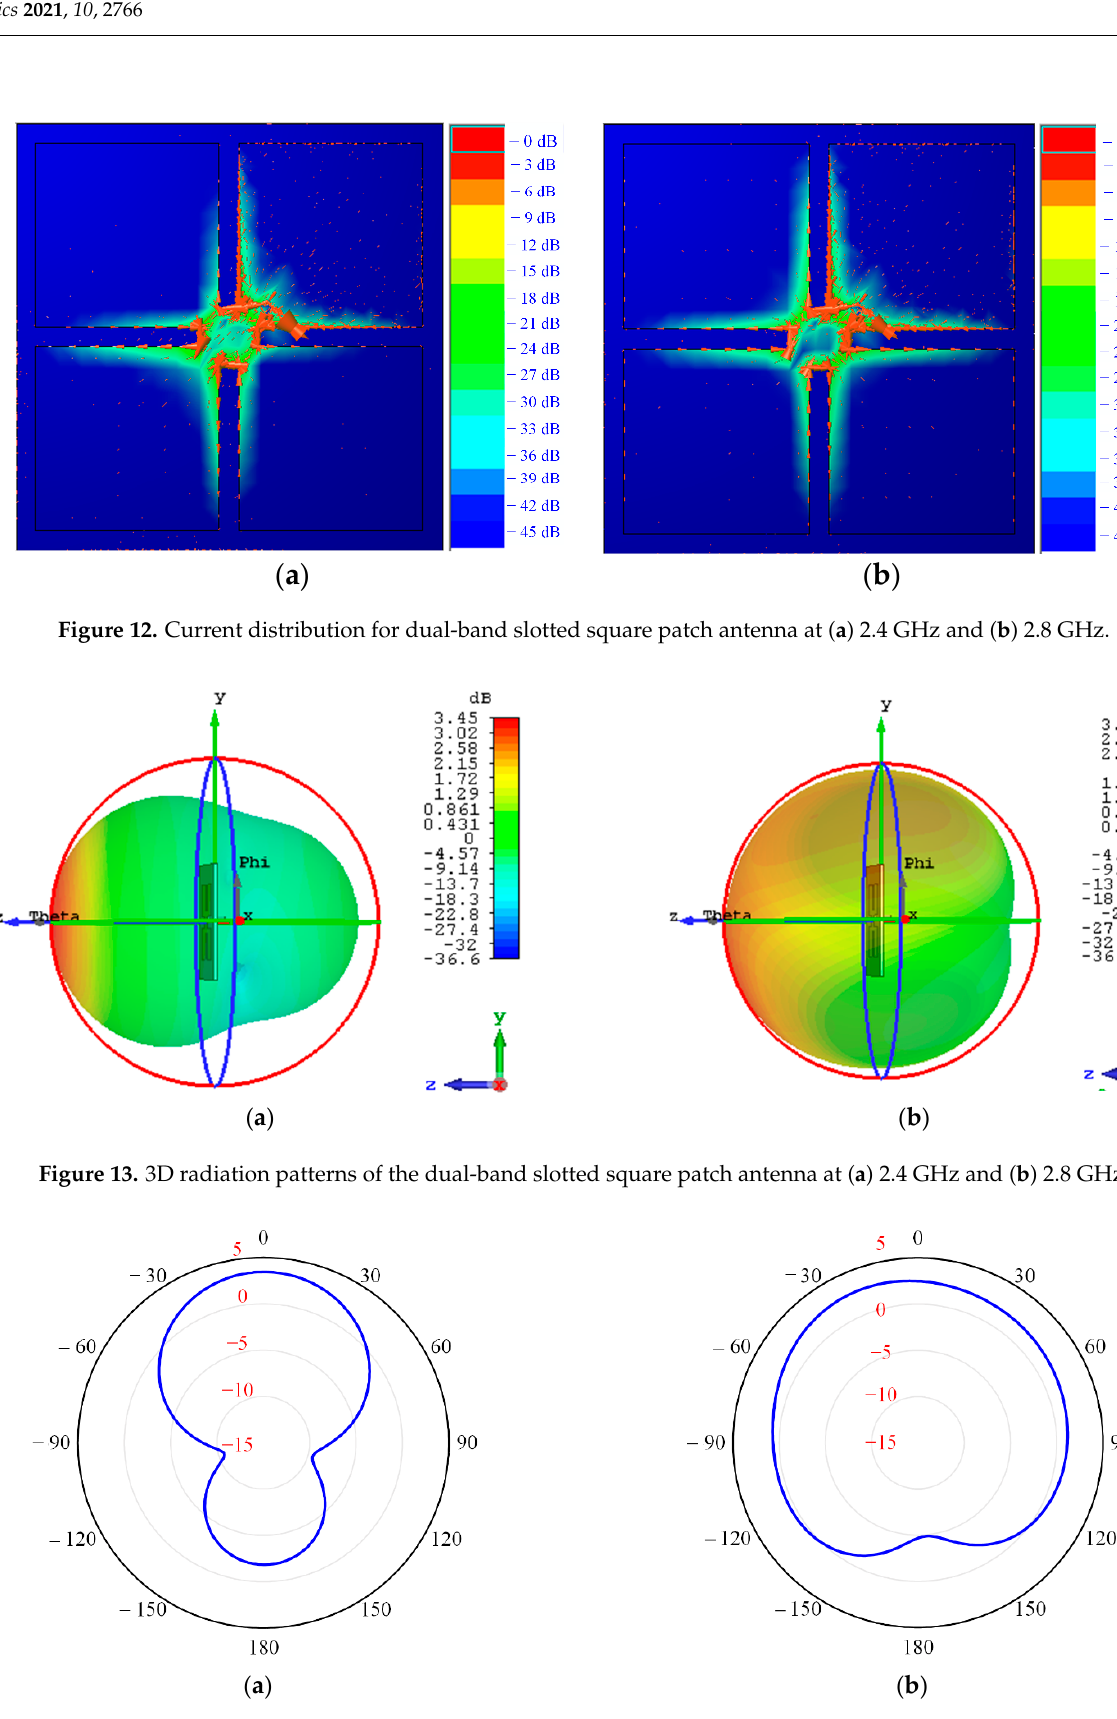
Figure 14. 2D radiation patterns of the dual-band slotted square patch antenna at ( a ) 2.4 GHz and ( b ) 2.8 GHz.